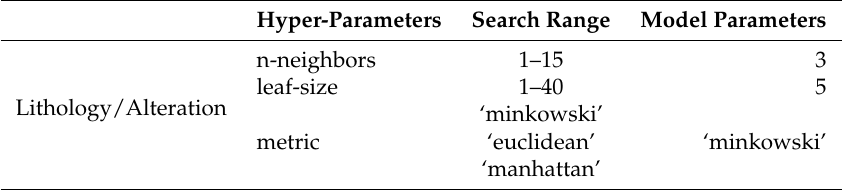
Table 3. Hyper-parameters for the k-nearest neighbours (kNN) model.